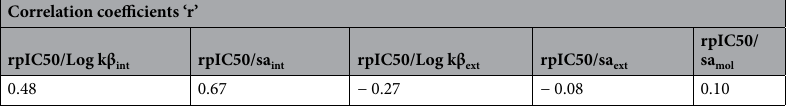
Table 6. Correlation coefficients ‘r’ calculated between pIC50s and hydrogen-bond acceptor strengths generated by Jazzy (sa int , sa ext , sa mol ) and Robb and colleagues (Log kβ int , Log kβ ext ) for the acceptor nitrogens of the pyrazolopyrimidine. The formula used for the calculation of ‘r’ is reported in the Supplementary